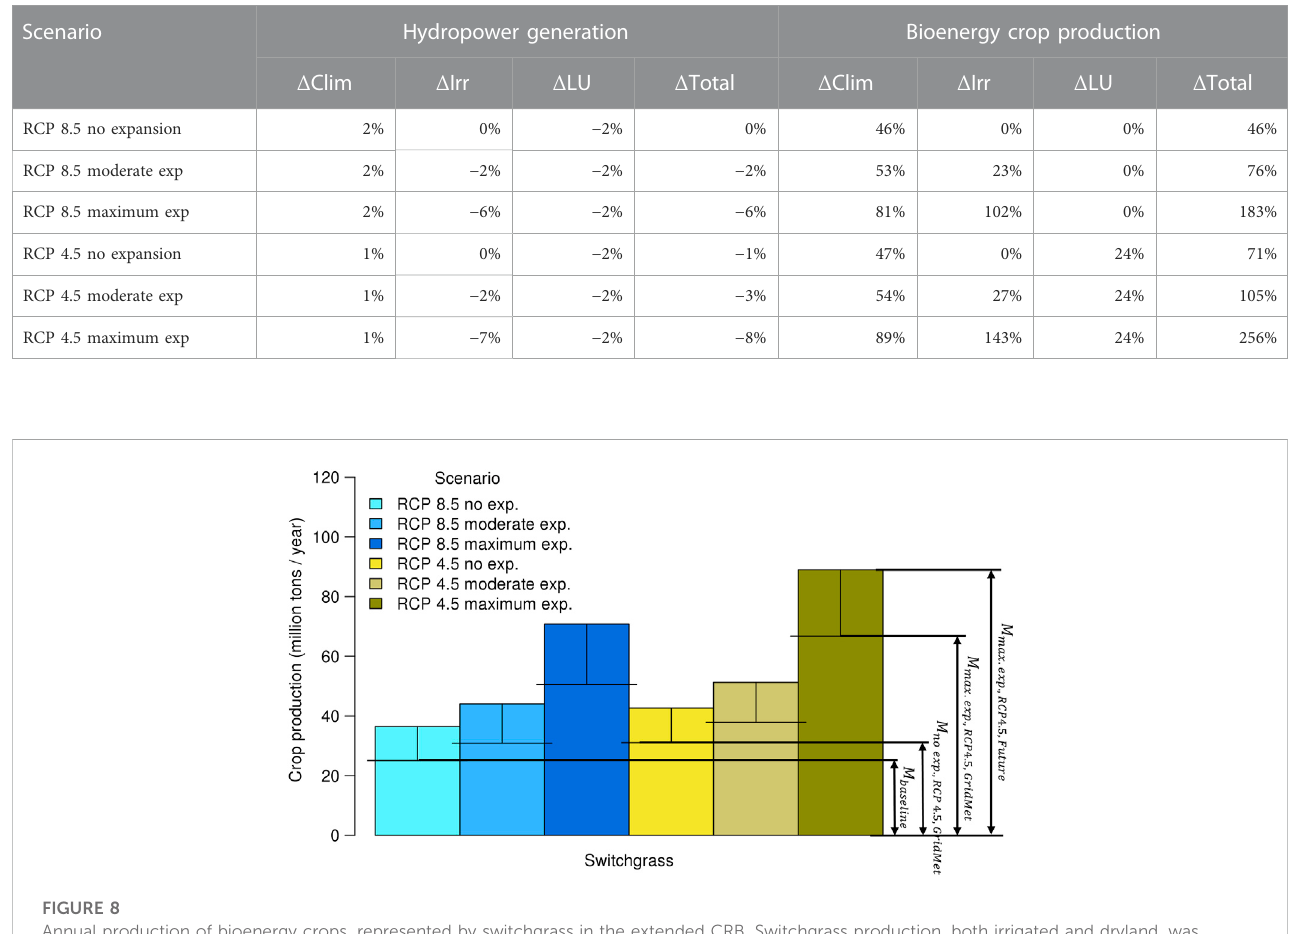
TABLE 3 Response of hydropower generation and bioenergy crop production to climate change ( Δ Clim ), land-use change ( Δ LU ), and irrigation expansion ( Δ Irr ). Hydropower generation is normalized by the GCAM baseline scenario and Bioenergy production is normalized by the RCP 8.5 no expansion scenario. The monthly